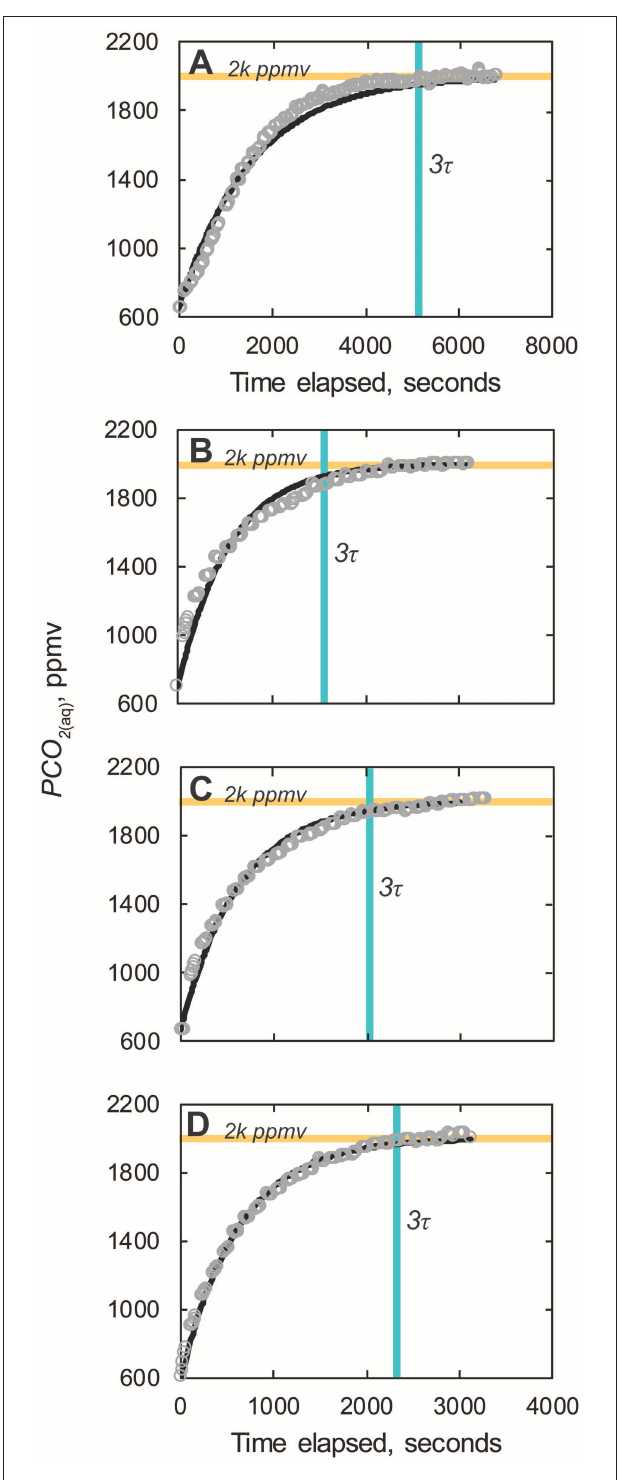
FIGURE 7 | (A) PCO 2(aq) measured during injection of 2,000 ppmv CO 2 reference gas. (B–D) PCO 2(aq) measured re-equilibration after equilibration of water to reference gas. Modeled exponential fits are solid black lines. Horizontal orange line, 2k ppmv, denotes 2,000 reference PCO 2(aq) value. Vertical blue line indicated three e-folding time, 3 τ , or ∼ 95% equilibration. Measurements made using the K30 1% gas